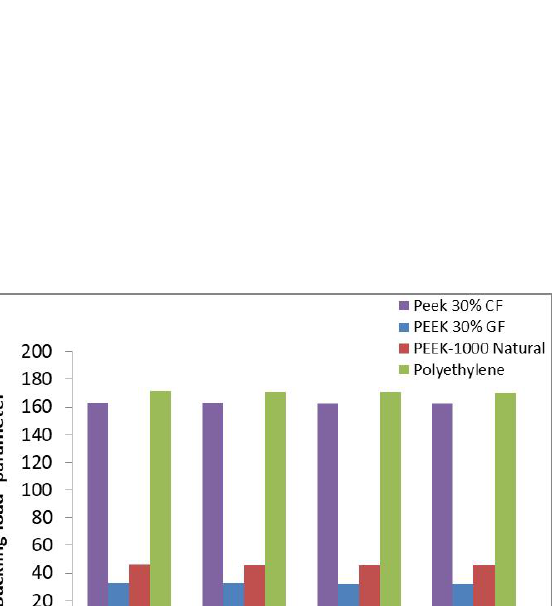
Fig. 6. Buckling load parameter results for different ( a / b ) at k =10, β =0.3, a / h =50 and skins height 2 mm